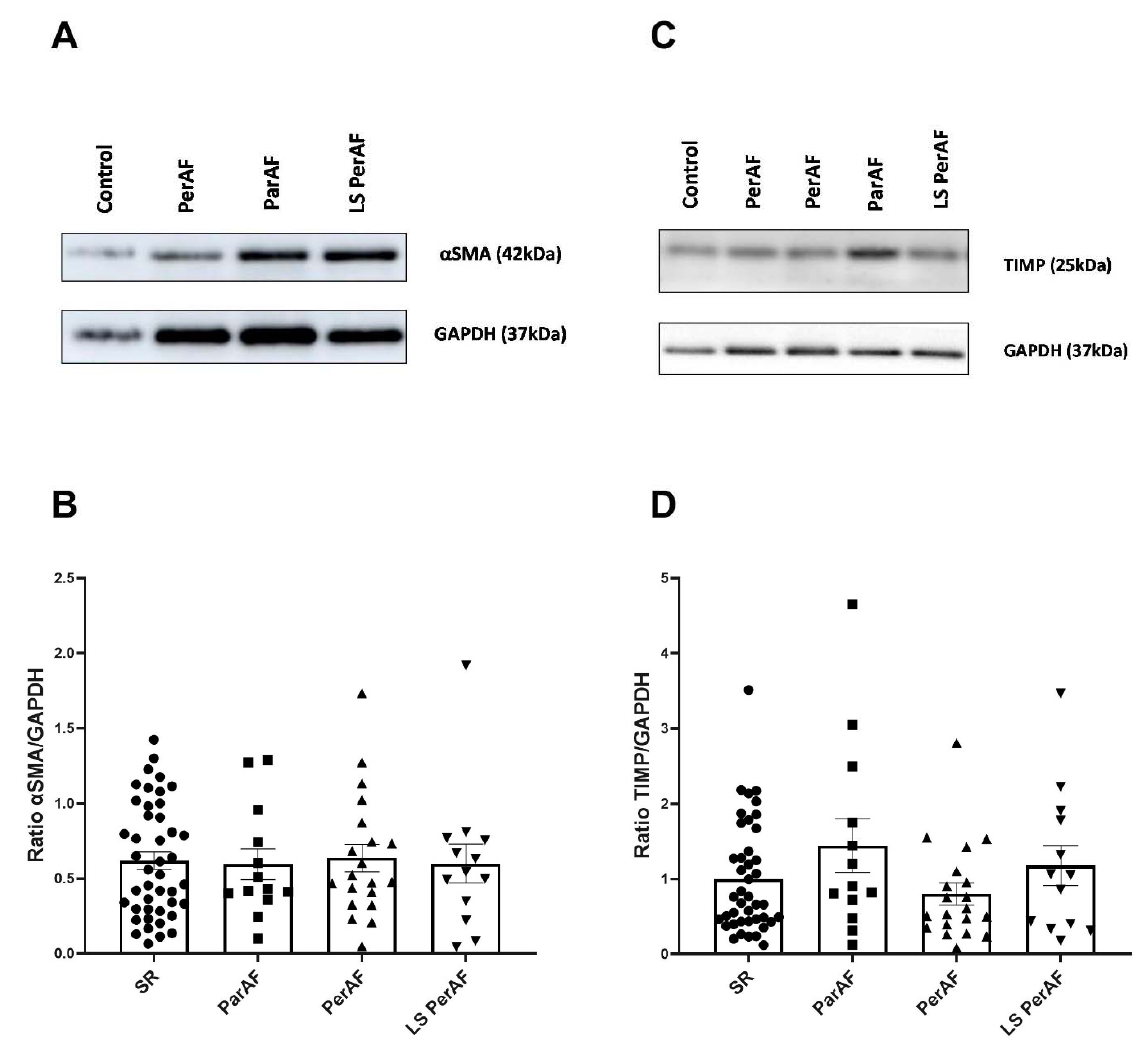
Figure 3. Cardiac myofibroblast ( α SMA) marker and metalloproteinase inhibitor factor (TIMP). No significant difference was observed between various stages of AF and the control SR group regarding α SMA (N = 91) and TIMP (N = 89); respectively p = 0.99, ( B ), and p = 0.41, ( D ). Representative blot images for α SMA and TIMP expression are illustrated in ( A , C ), respectively. SR = control group, ParAF = paroxysmal atrial fibrillation, PerAF = persistent atrial fibrillation, LSPerAF = longstanding persistent atrial fibrillation. Statistical tests used: ANOVA.